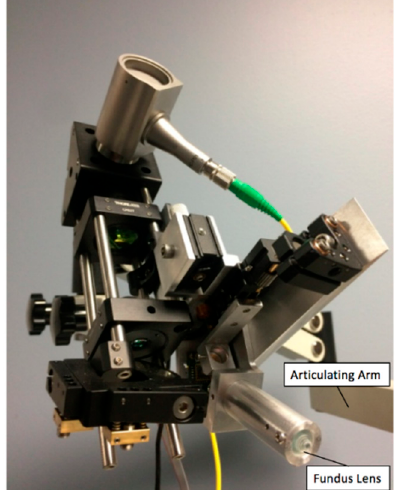
Figure 6. SAR-OCT mount was designed in a CAD software using off-the-shelf components from ThorLabs and custom aluminum parts to mount the optics compactly and securely. Permission was granted by the publisher to reprint this figure from Gardner et al. with minor modifications [19].